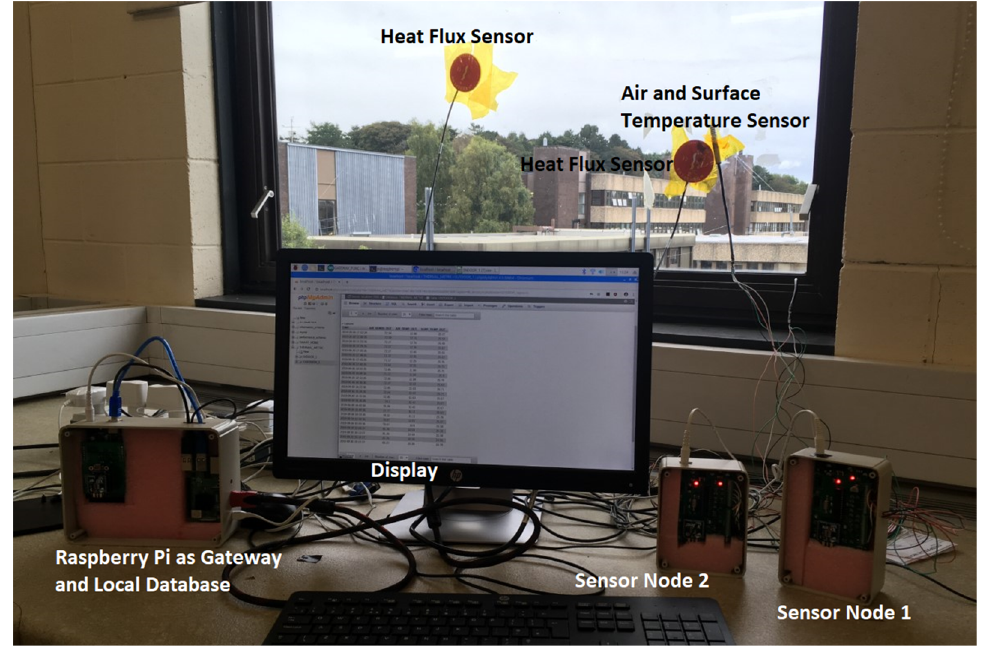
Figure 4. Measurement setup of the proposed platform.